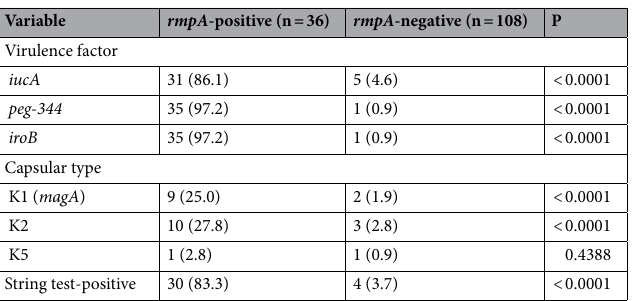
Table 1. Microbiological characteristics of rmpA -positive and rmpA -negative K. pneumoniae isolates from patients with bloodstream infections. Data are expressed as number